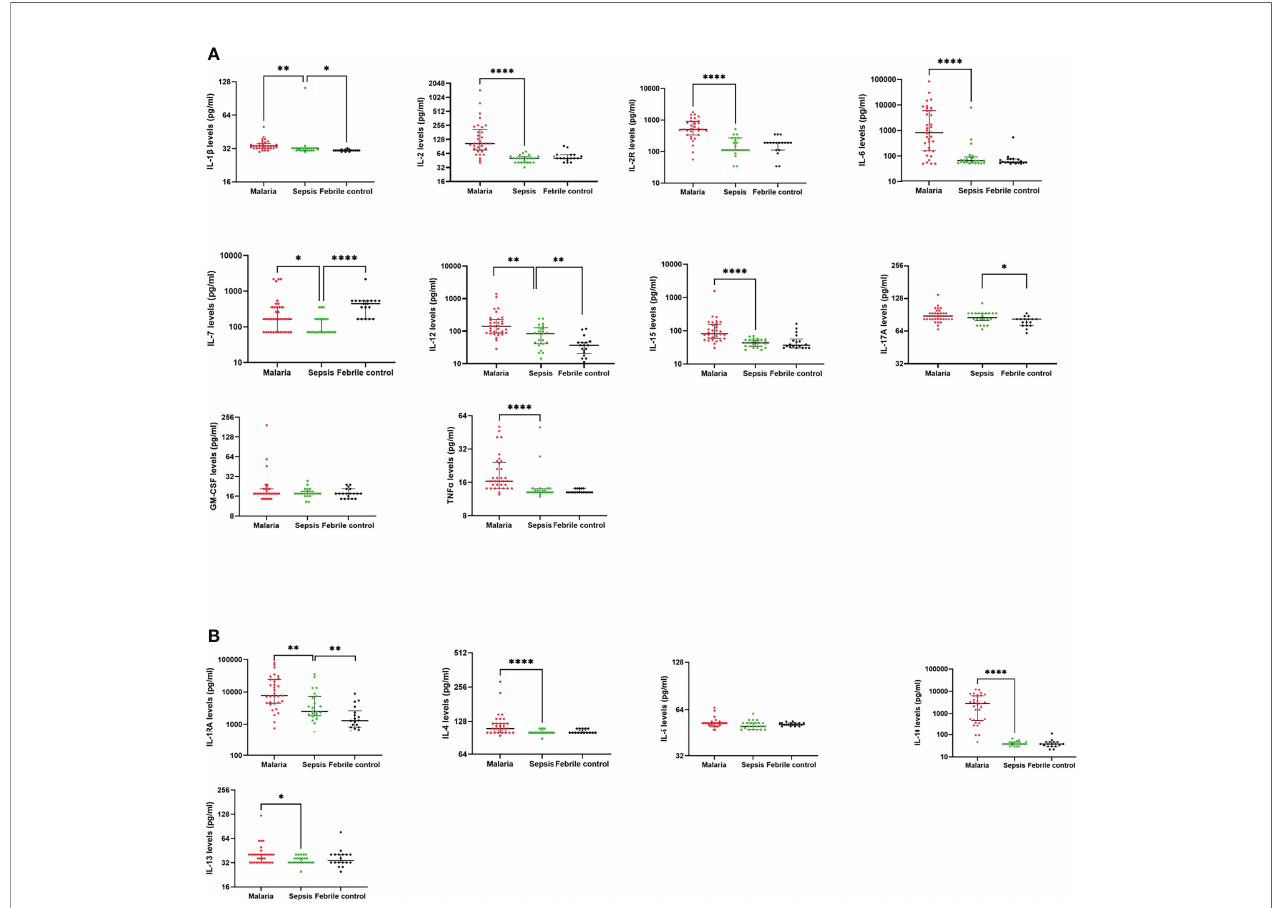
FIGURE 2 | Children with sepsis show a lower anti-in fl ammatory pro fi le compared to children with clinical malaria. The scatter plots show the plasma levels (pg/ml) of (A) pro-in fl ammatory cytokines, (B) anti-in fl ammatory cytokines detected in children with clinical malaria, non-malaria sepsis and febrile controls. The plots show the median and interquartile ranges. Differences were considered when p < 0.05. Statistically signi fi cant values are denoted by *p < 0.05; **p < 0.01; ****p < 0.0001. Statistical analyses were performed using the Kruskal-Wallis with Dunn ’ s Multiple comparison correction